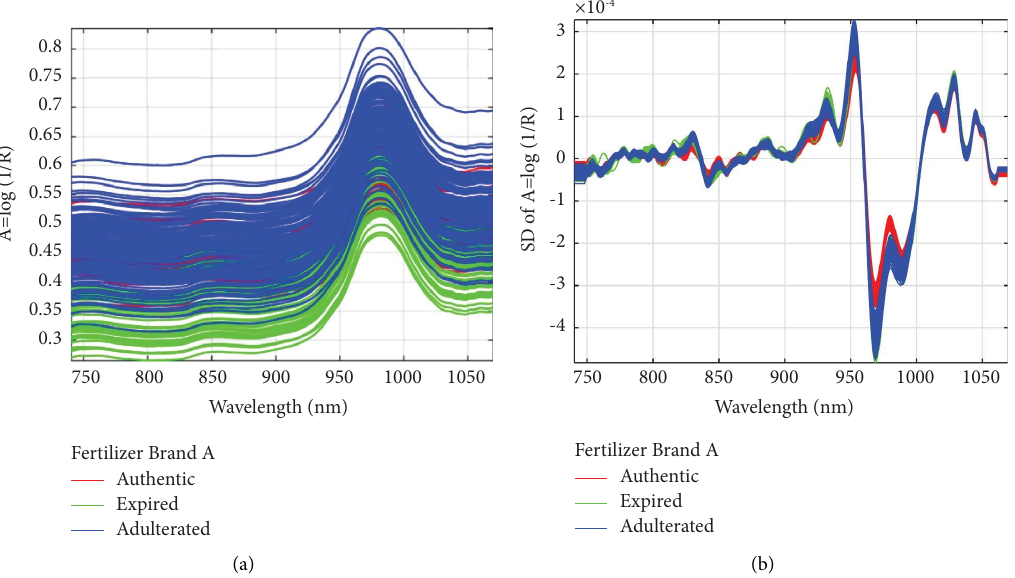
Figure 1: Spectra profle: (a) raw and (b) SGSD of fertilizer A